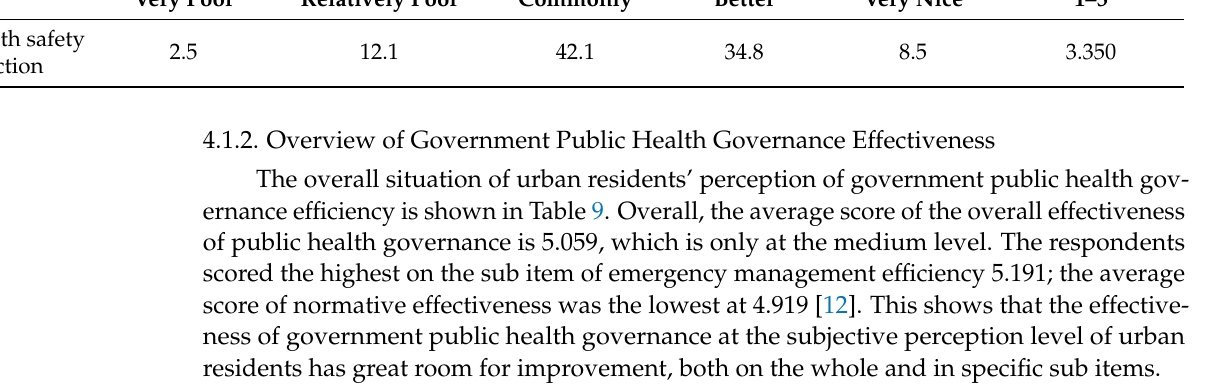
Table 9. Perceived effectiveness of government public health governance (unit: %).